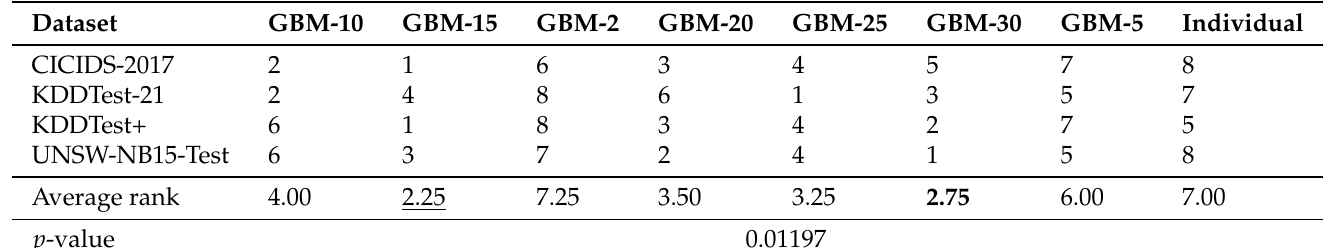
Table 3. Friedman rank matrix of all classifiers relative to each dataset with respect to MCC metric. Bold indicates the best rank, while the second best is underlined. The Friedman test indicates that performance differences across algorithms are significant ( p -value < 0.05).